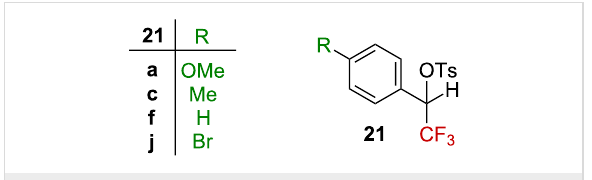
Figure 4: Structure of tosylate derivatives 21 .